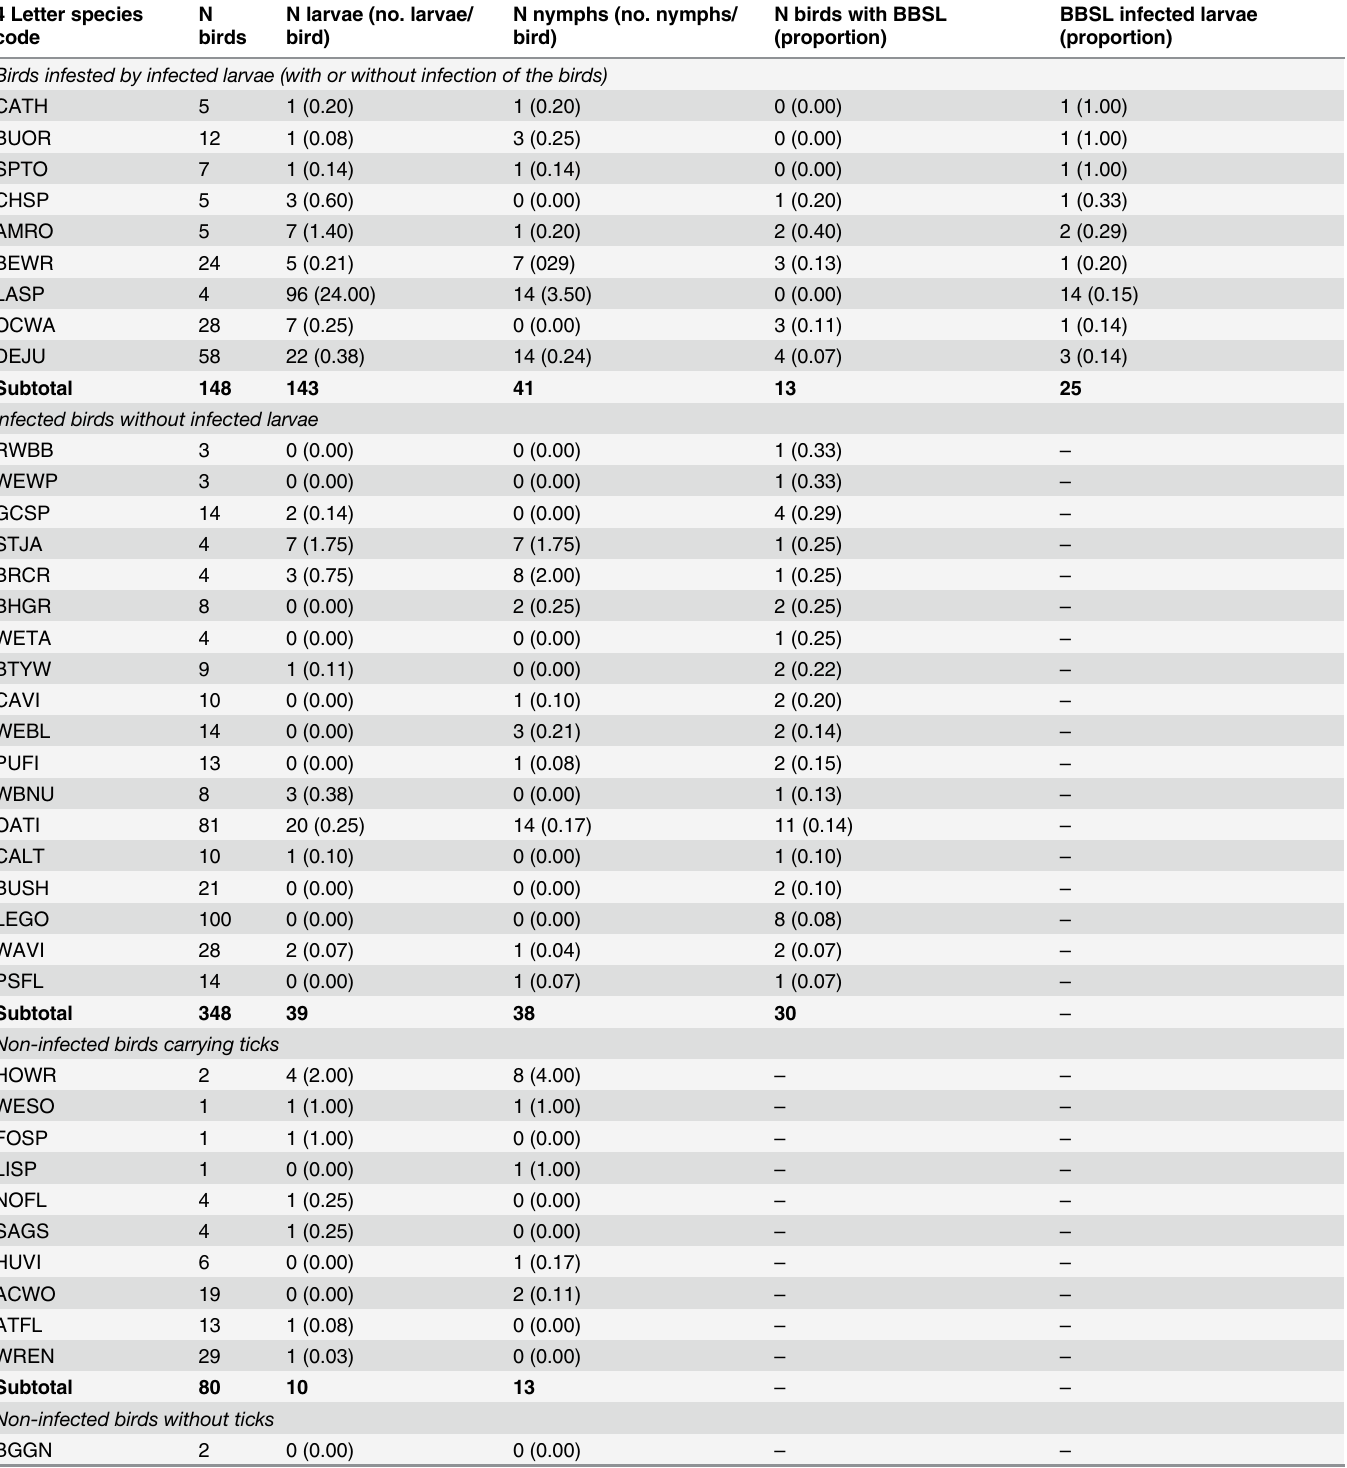
Table 4. Summary of Ixodes paci fi cus infestation on birds, Borrelia burgdorferi s.l. (BBSL) infection in bird blood, and number of BBSL infected larvae by bird